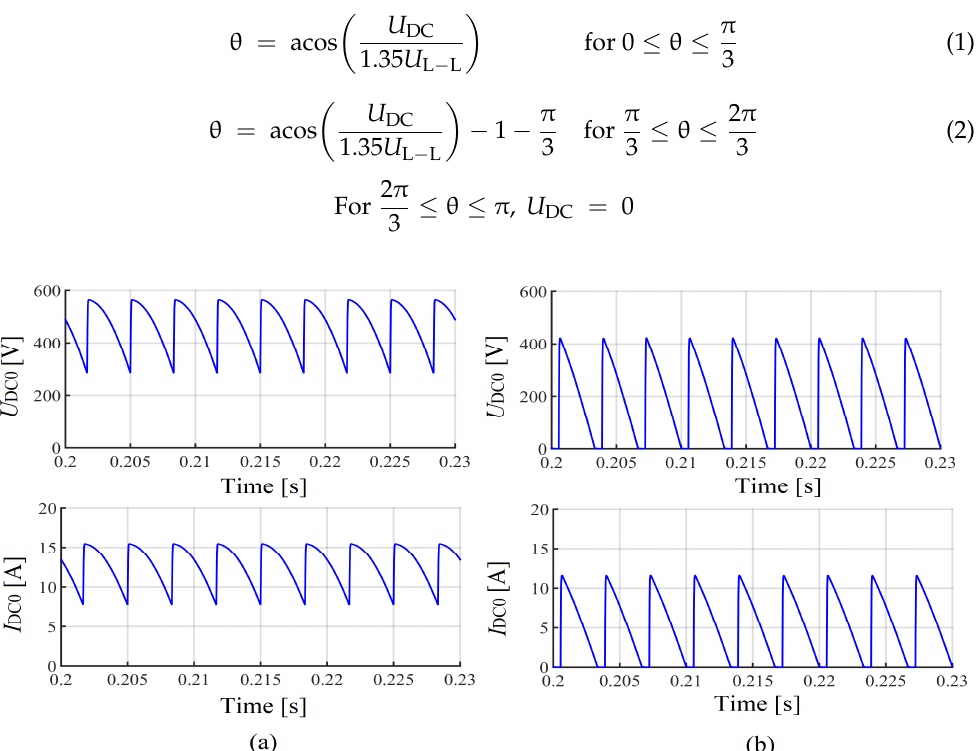
Figure 4. Voltage and current at the rectifier DC side for different firing angle values: ( a ) continuous mode (θ = 30°); ( b ) discontinuous mode (θ = 60°) (from simulation).